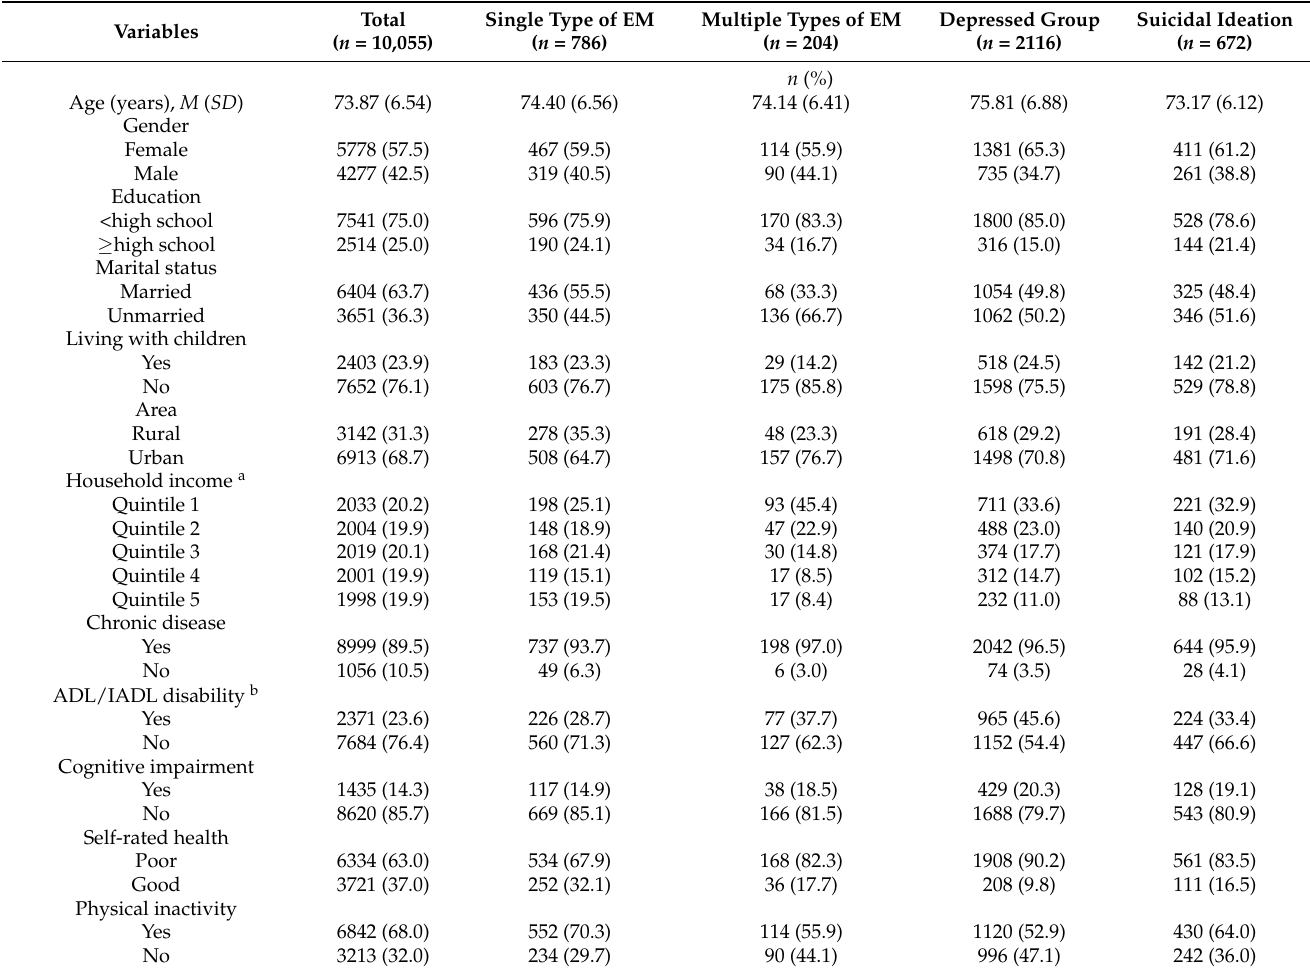
Table 1. Characteristics of the study participants